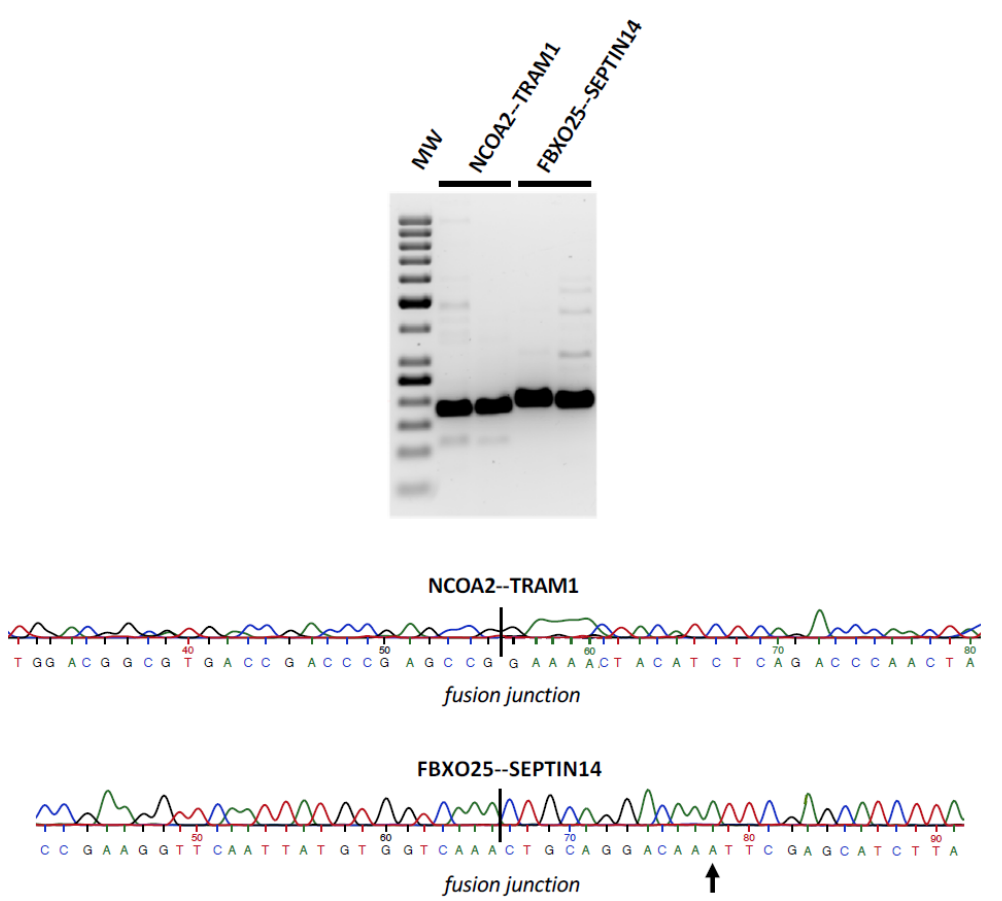
Figure 3. Electrophoresis and sequence of the NC0A2--TRAM1 and FBXO25--SEPTIN14 fusion PCR products. Agarose gel electrophoresis of PCR products generated from cDNA of the cerebellar sam- ples 83 and 86 for the NC0A2--TRAM1 and FBXO25--SEPTIN14 fusions, respectively, using primer pairs specific for each fusion (Materials and Methods). MW, molecular weight markers. The elec- tropherograms of the sequenced PCR products, with the fusion junction indicated, is shown. Note the presence of an A nucleotide at position 12 of the SEPTIN14 sequence, indicated by an arrow, instead of the anticipated G